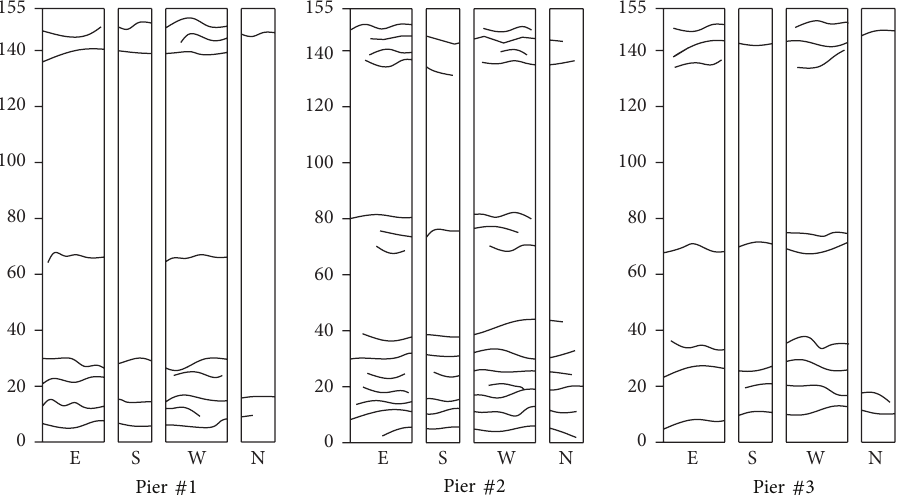
Figure 6: Pier’s crack distribution (unit: cm).